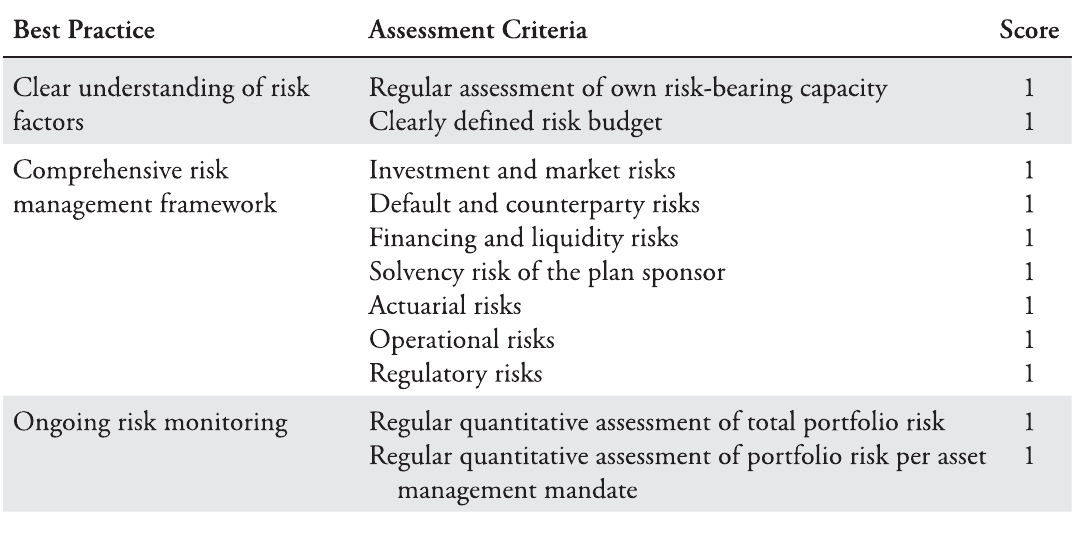
Table 5: Composition of the RIMA